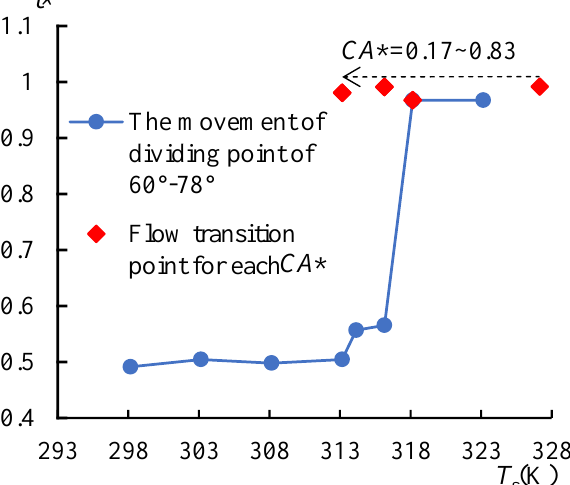
Figure 18. The position of dividing points vs. heating temperature. The diving points moved rightwards with the increasing T s . For the increased CA *, the single-vortex flow (transition point) formed at a lower heating temperature.